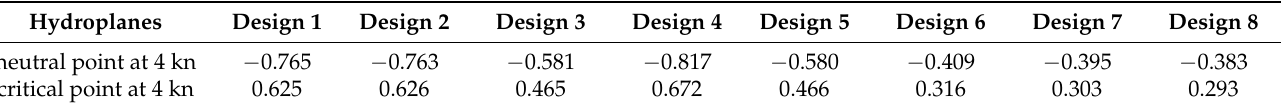
Table 8. The distance non-dimensionalized by L for the neutral and critical point along the center line from the origin or center of